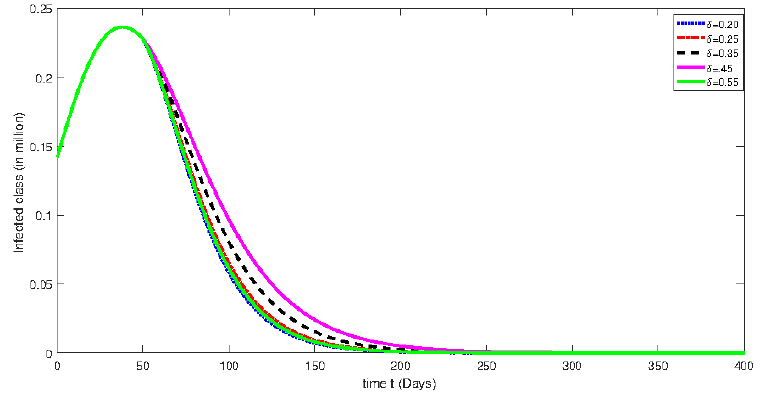
Figure 11. Numerical solution for susceptible class for the given days and using different fractional orders with isolation rate of 70%.